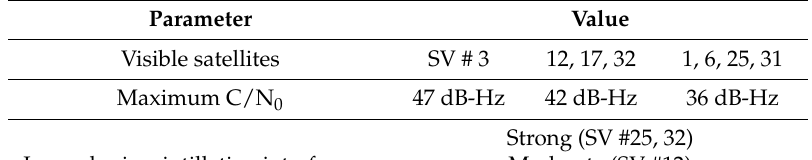
Table 6. The parameters of the set of dynamic data.